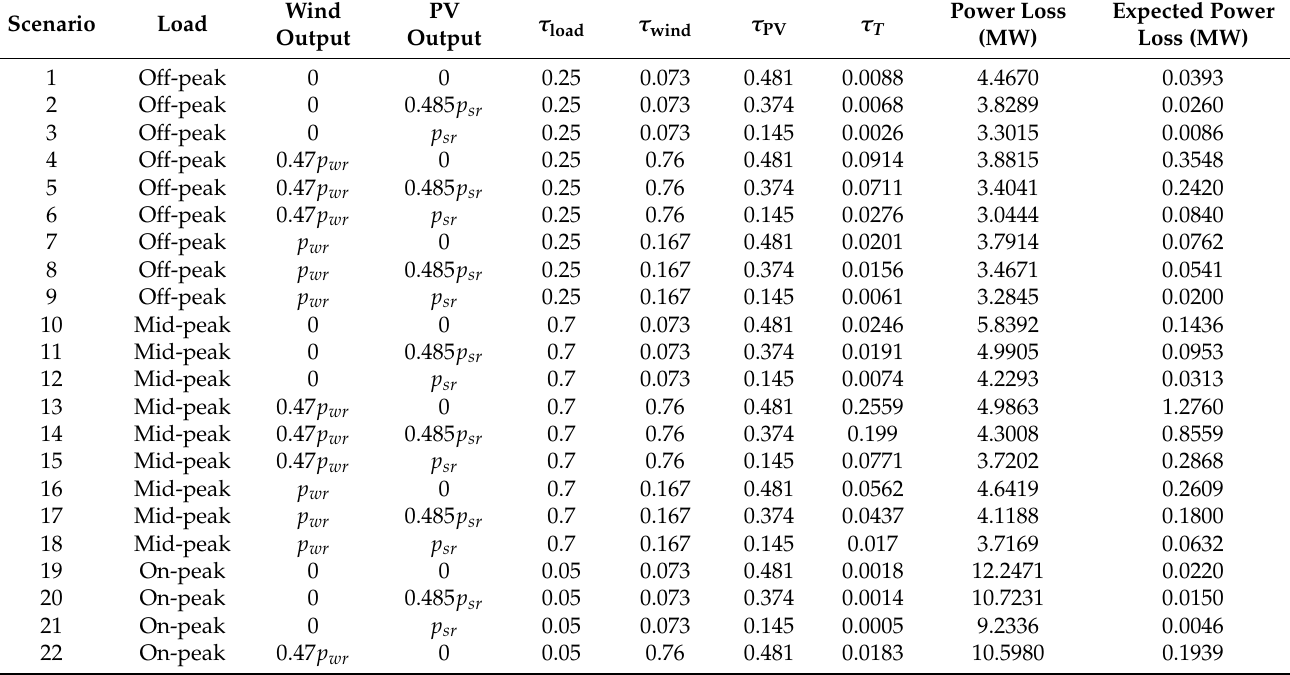
Table 5. Results of RES-based studied scenarios optimized using the proposed